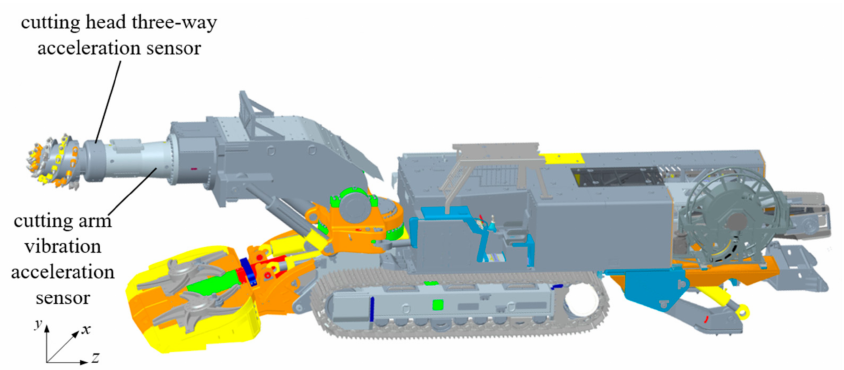
Figure 8. Measuring point and sensor arrangement of the roadheader. x . y , and z are the directions of the coordinate system established in the tunnel.